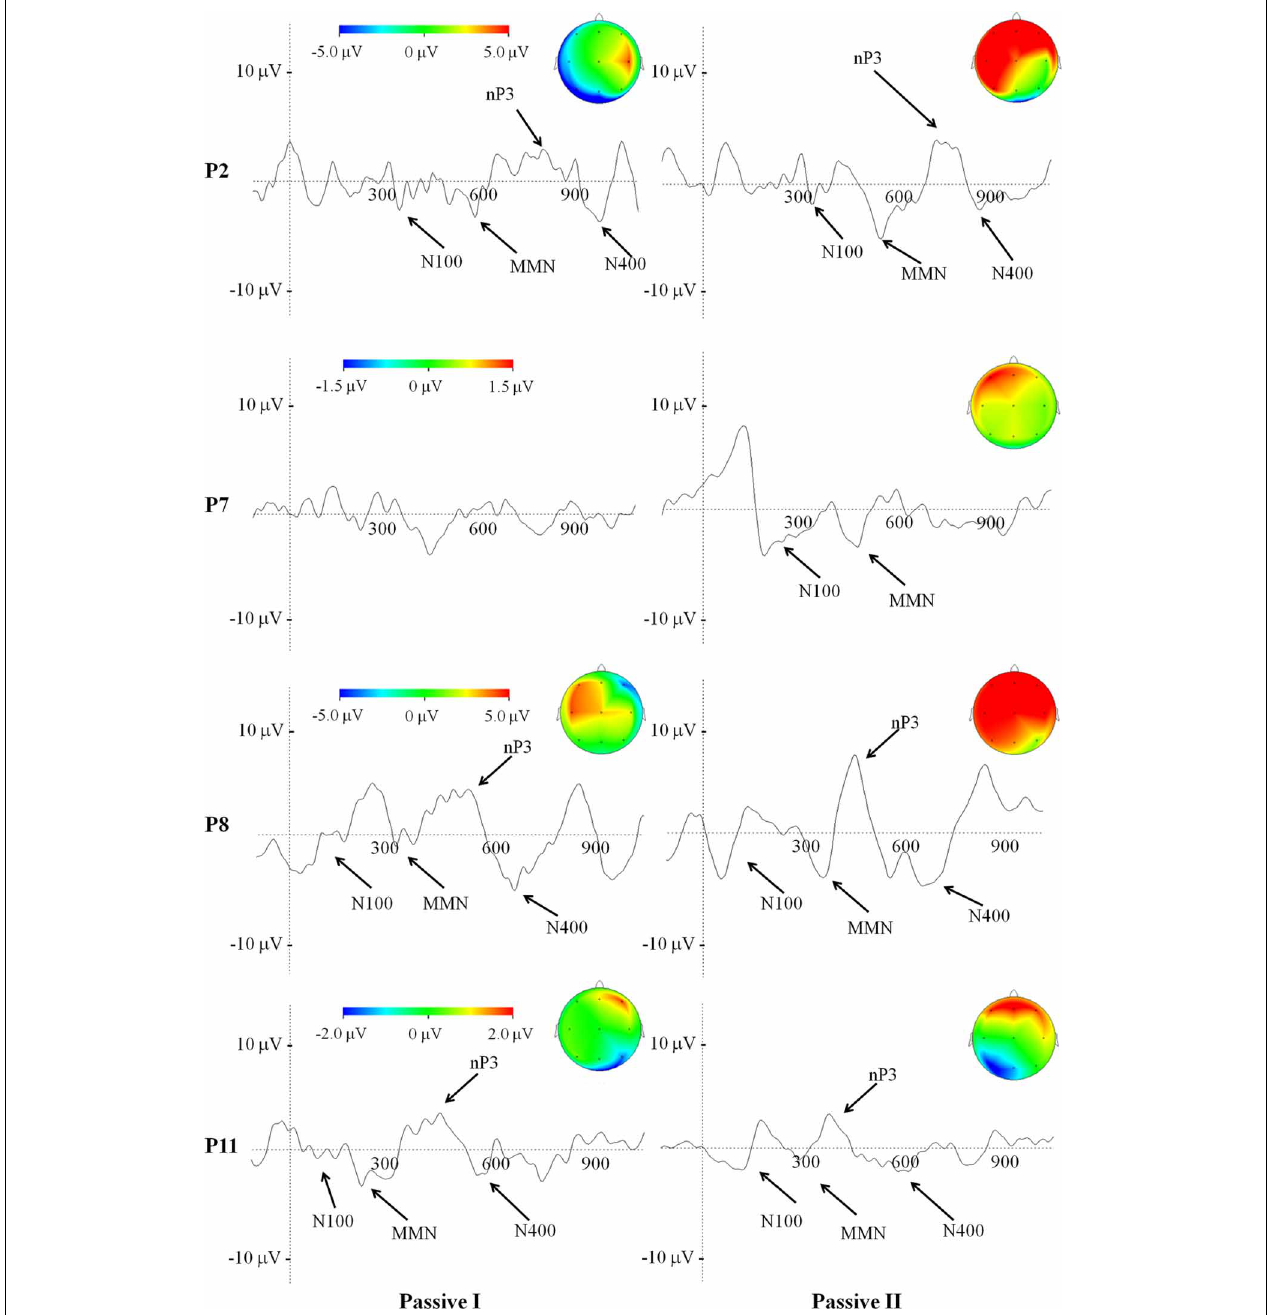
FIGURE 3 | Average of ERP waveforms and scalp potential topography depicted at Cz of passive condition related to the first and to the second recording session, in patients who underwent a change in their clinical